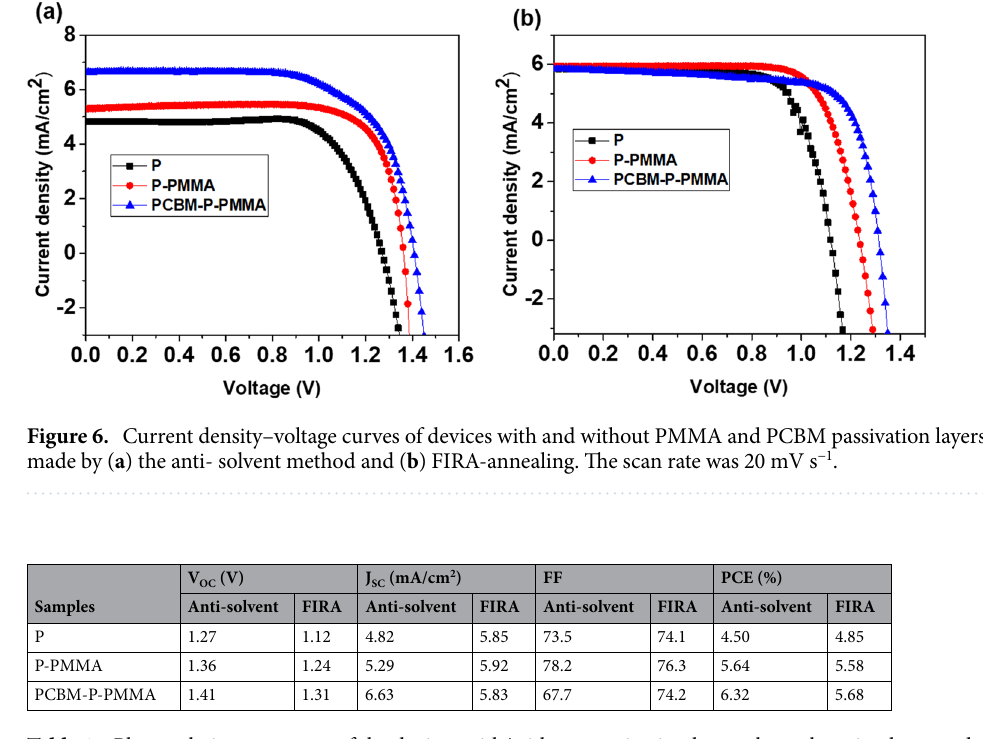
Table 1. Photovoltaic parameters of the devices with/without passivation layers through anti-solvent and FIRA.